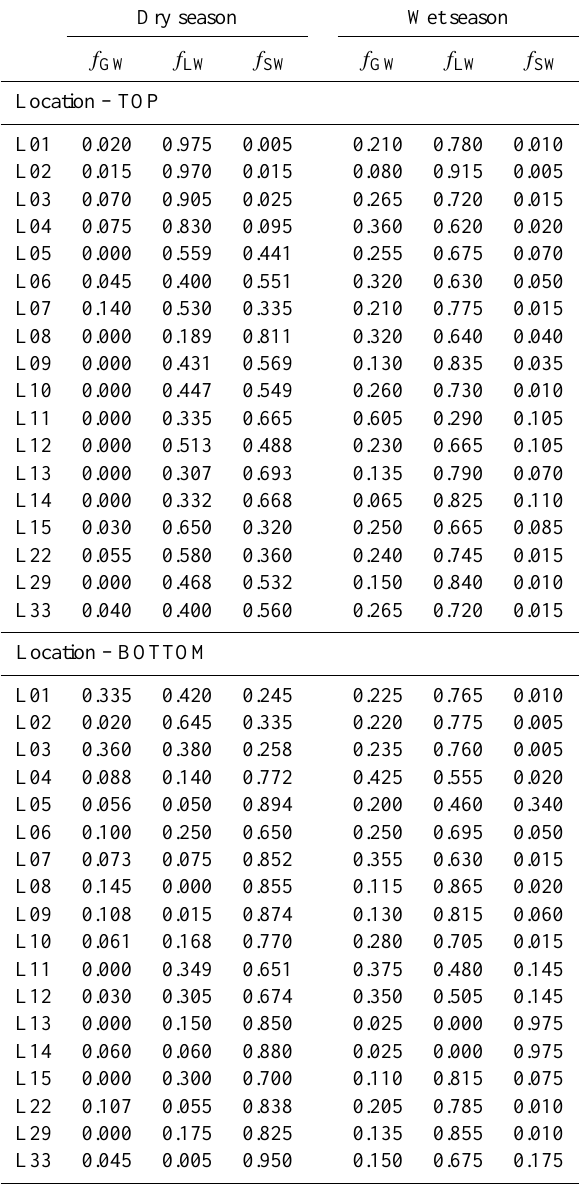
Table 2. Average results of the three component endmember mixing analysis giving the contributions of groundwater ( f GW ) , lake water ( f LW ) and seawater ( f SW ) in the lagoon top and bottom for dry and wet